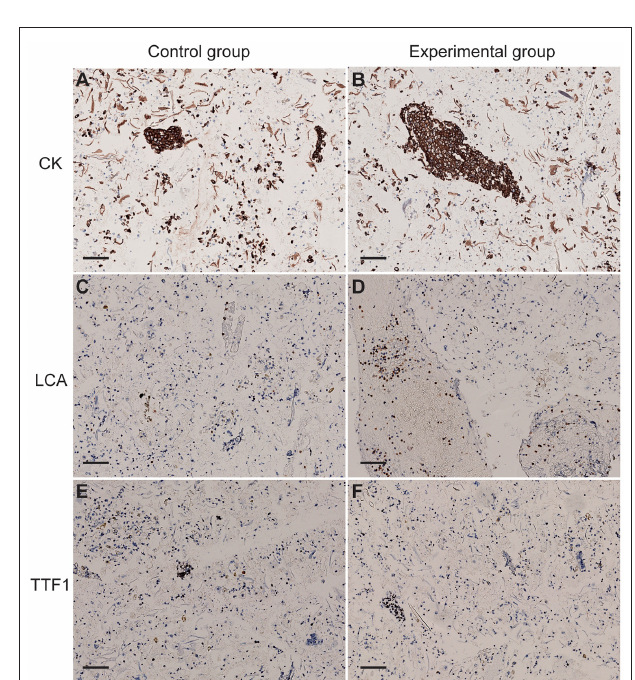
FIGURE 4 | The expression of cytokeratin (CK), leukocyte common antigen (LCA), and thyroid transcription factor-1 (TTF1) and in cells of sputum. (A,B) CK was expressed on the membrane of cells in the control group and the experimental group. (C,D) LCA was expressed in the cytoplasm of cells in the control group and the experimental group. (E,F) TTF1 was expressed in the nucleus of cells in the control group and the experimental group. Scale bar = 100 µ